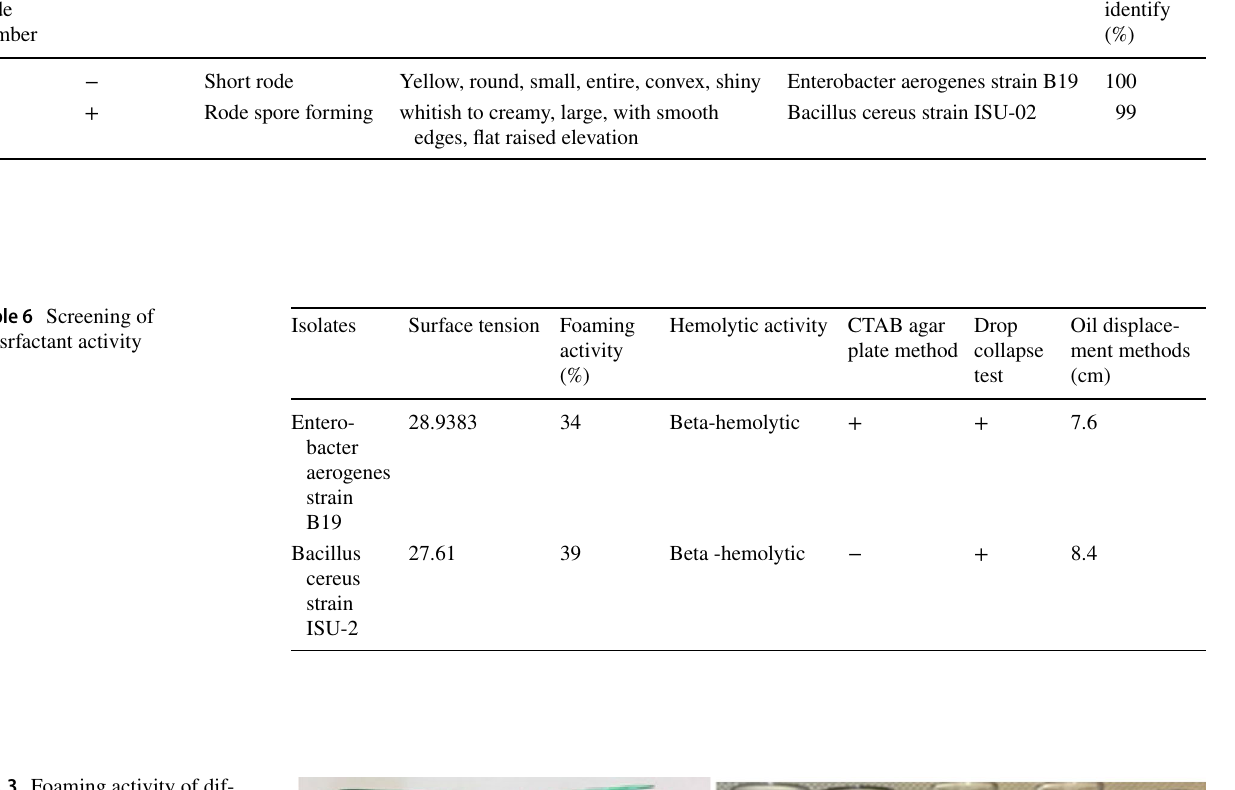
Fig. 3 Foaming activity of dif- ferent strains comparing with